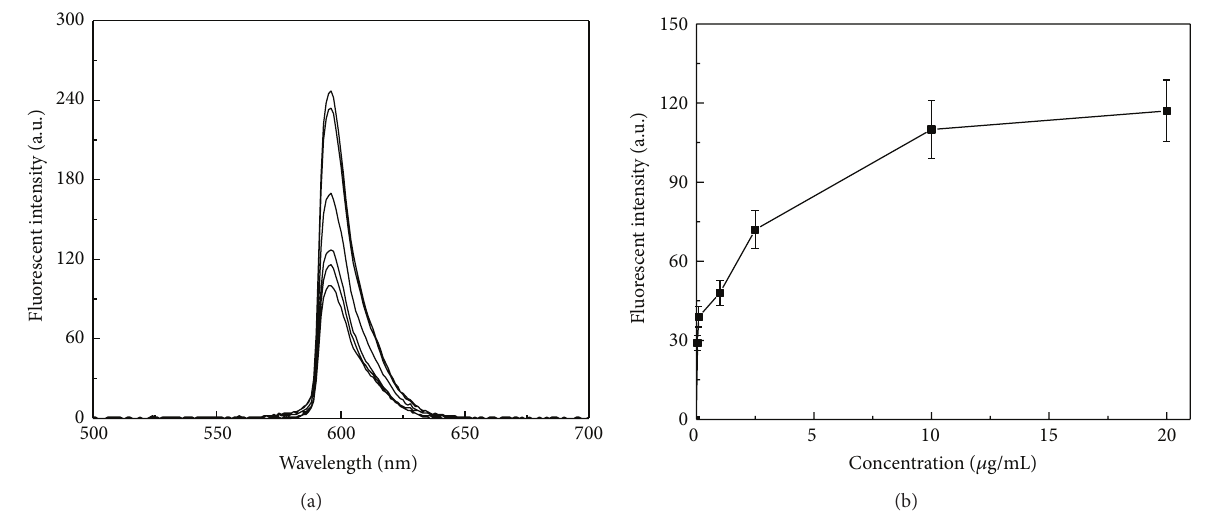
Figure 8: (a) The fluorescent intensities for the detection of antibody and (b) the relation between intensity and antibody concentration (50 ng/mL, 500 ng/mL, 1 𝜇 g/mL, 2.5 𝜇 g/mL, 10 𝜇 g/mL, and 20 𝜇 g/mL); Δ𝐼 = 𝐼 2 − 2 × 𝐼 1 . The exposure time is 600